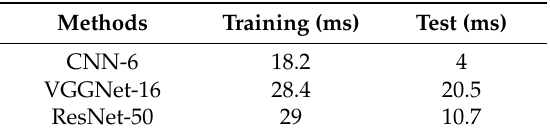
Table 4. Training and testing time of CNNs on DS_Original dataset.